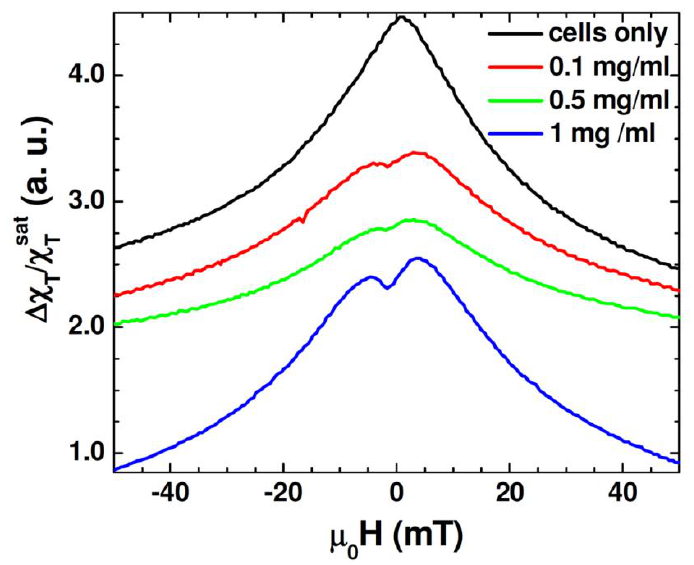
Figure 6. Transverse susceptibility measurements of HEK cells with varying concentrations of Au-Fe O nanoparticles. The black scan is for the cells without any 3 4 nanoparticles. The scans have been shifted vertically to better compare the characteristics of each